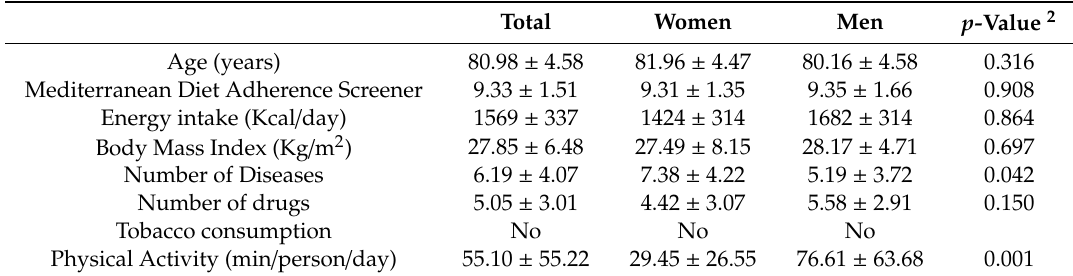
Table 2. General characteristics of the participants 1